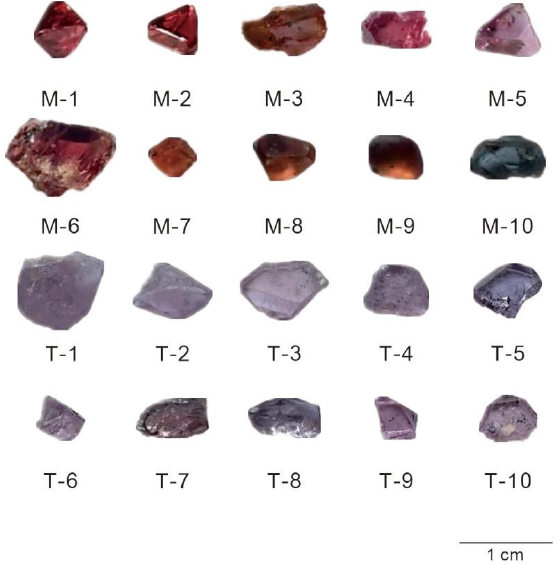
Figure 2. The twenty different samples of spinels studied. (M—Myanmar; T—Tajikistan.)